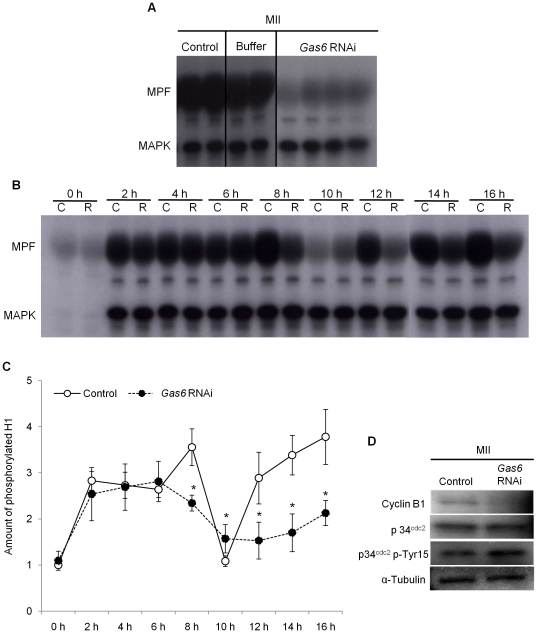

Gas6 RNAi impaired reactivation of MPF after emission of the first polar body.(A) To assess the activities of MPF and MAPK after Gas6 RNAi, phosphorylation of the substrates histone H1 and MBP, reflecting the kinase activities of MPF and MAPK, respectively, was determined. Each lane contained one MII stage oocyte. Control, uninjected oocytes; Buffer, buffer-injected for sham control oocytes; Gas6 RNAi, Gas6 dsRNA-injected oocytes. (B) Dual kinase activity analysis to determine the phosphorylation levels of the substrates histone H1 and MBP was performed every 2 hours after Gas6 RNAi injection. C, uninjected control oocytes; R, Gas6-depleted oocytes. (C) The amount of phosphorylated histone H1 was calculated, and relative amounts were presented in line graphs. Asterisks represent statistical significance at p<0.05. Intact line with open circles, Control, uninjected oocytes; Dotted line with closed circles, Gas6 RNAi, Gas6-silenced oocytes. (D) Western blot analysis of cyclin B1, p34cdc2, and p34cdc2 p-Tyr15 in MII oocytes after Gas6 RNAi treatment. Depletion of GAS6 protein after Gas6 RNAi treatment affected MPF activity. Protein lysates of 250 MII oocytes were loaded per lane. α-Tubulin was used as a loading control. Control, uninjected control MII oocytes; Gas6 RNAi, Gas6-silenced MII oocytes.